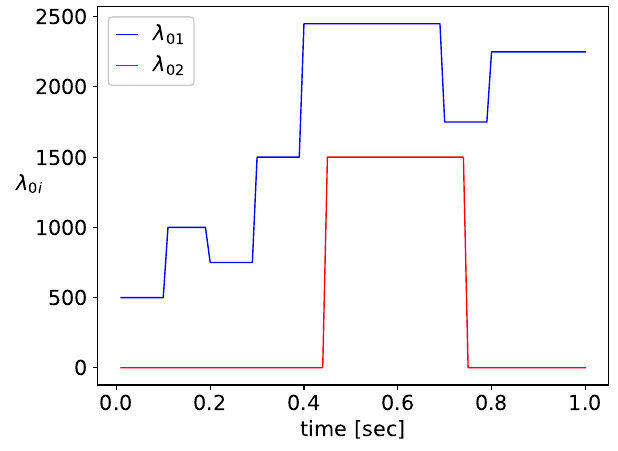
Figure 10. Input flows λ 01 ( t ) , λ 02 ( t ) , time in